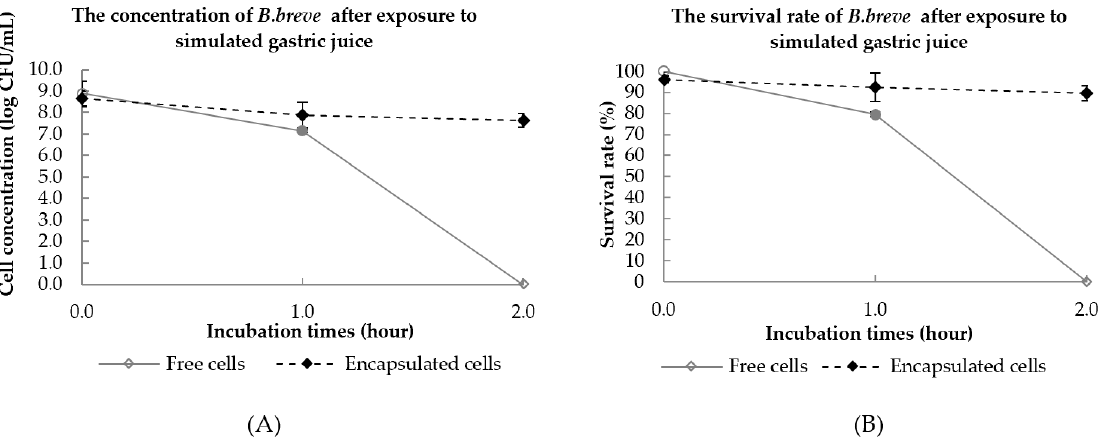
Figure 3. Total viable cell count (log CFU/mL) ( A ) and survival rates (%) ( B ) of free and encapsulated B. breve TISTR 2130 in simulated gastric juice (pH 2.0) during incubation at 37 °C for 2 h ( n = 3, bars indicate the standard deviation).